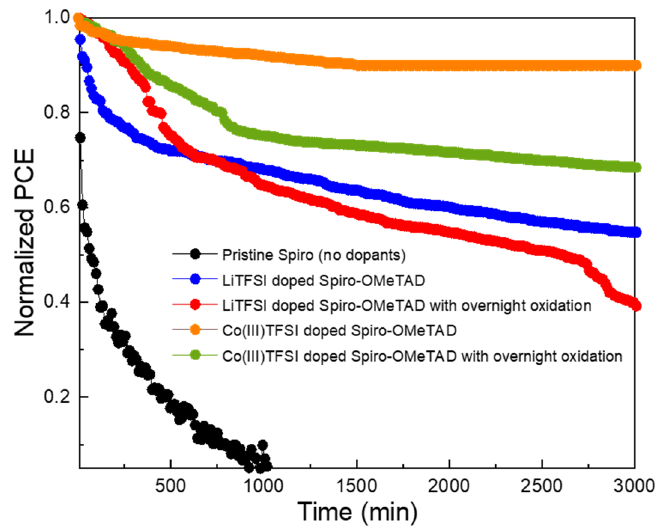
Figure 5. Stability analysis by the MPP tracking of perovskite solar cells with pristine spiro-OMeTAD, LiTFSI-doped spiro-OMeTAD, and Co(III)TFSI co-doped spiro-OMeTAD with and without overnight oxidation.